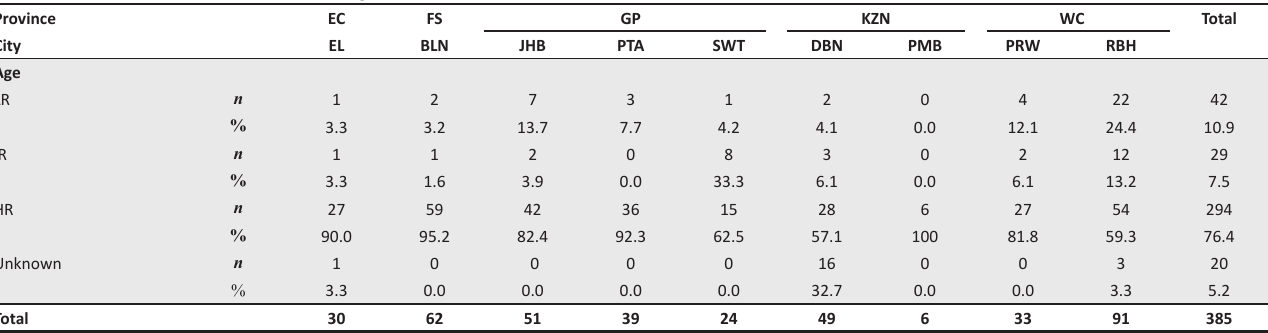
INSS, International Neuroblastoma Staging System; EC, Eastern Cape; FS, Free State; GP, Gauteng; KZN, KwaZulu-Natal; WC, Western Cape; LR, low-risk; IR, intermediate risk; HR, high-risk. TABLE 6: Neuroblastoma risk stratification at diagnosis from 2000 to 2014 in South Africa. Province